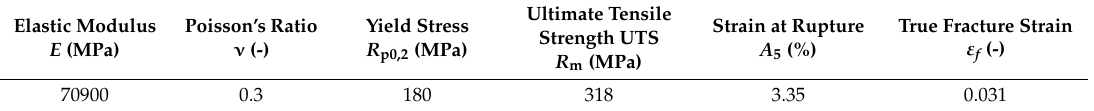
Table 2. Material parameters of the SLM AlSi10Mg alloy.